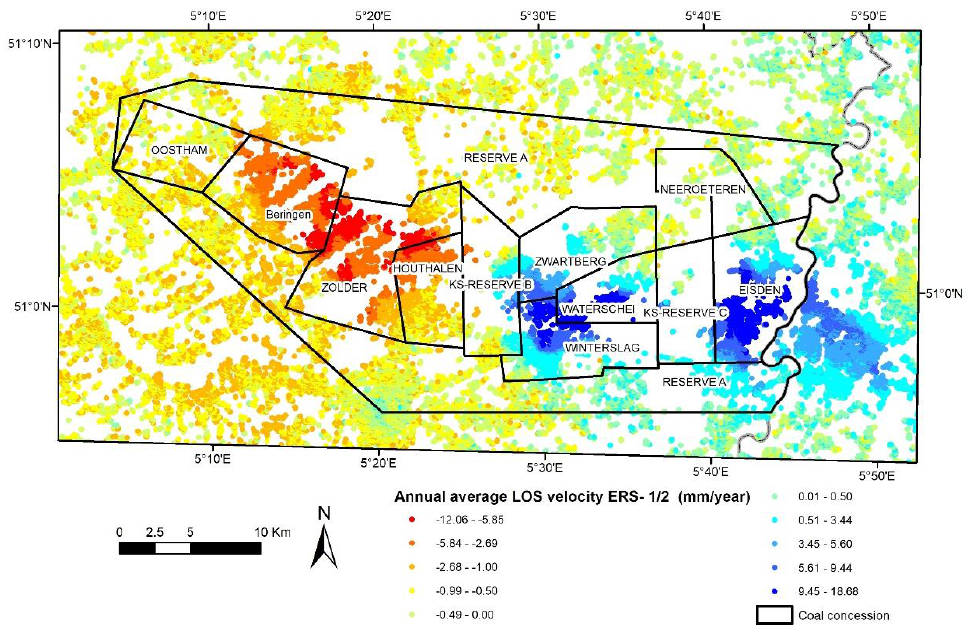
Figure 4. Color classification based on the average annual LOS velocities of PS points for ERS-1/2 (1992 – 2005) and the extension of the coal concessions in Limburg.